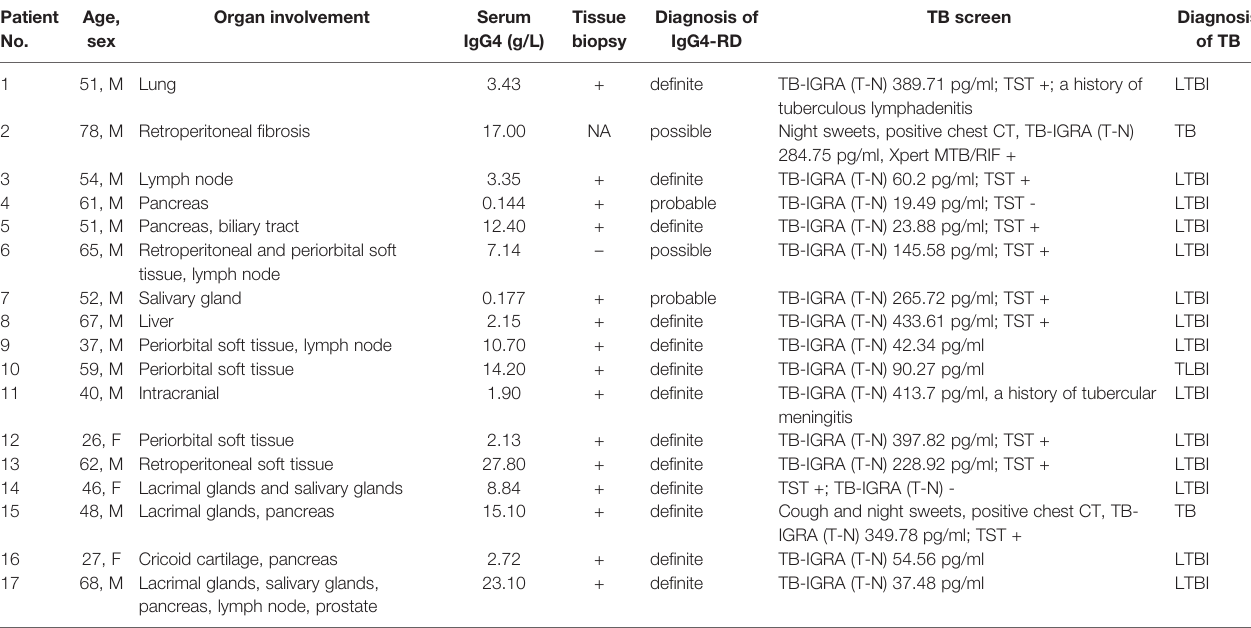
TABLE 2 | Characteristics of IgG4-related disease with tuberculosis infection in our cohort (2015-2020). Patient